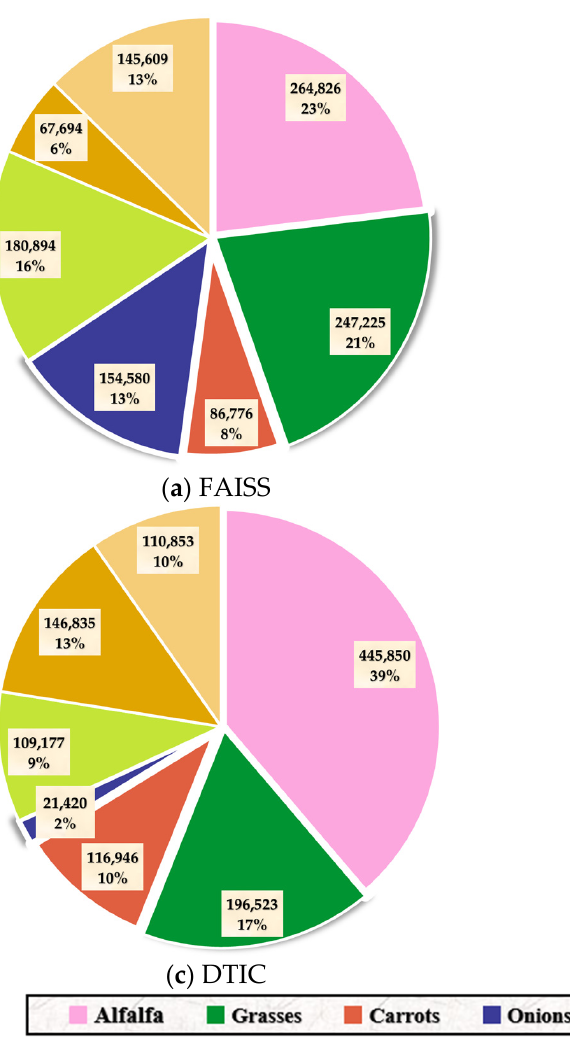
Figure 11. Quantity and percentage of each class on the Imperial Dataset using different methods implemented with random initial cluster centers. ( a ) FAISS; ( b ) K-means; ( c ) DTIC; ( d ) true proportion. Table 6. A comparison of different methods on the Imperial Dataset with averaged initial cluster centers. The bolded results show the best